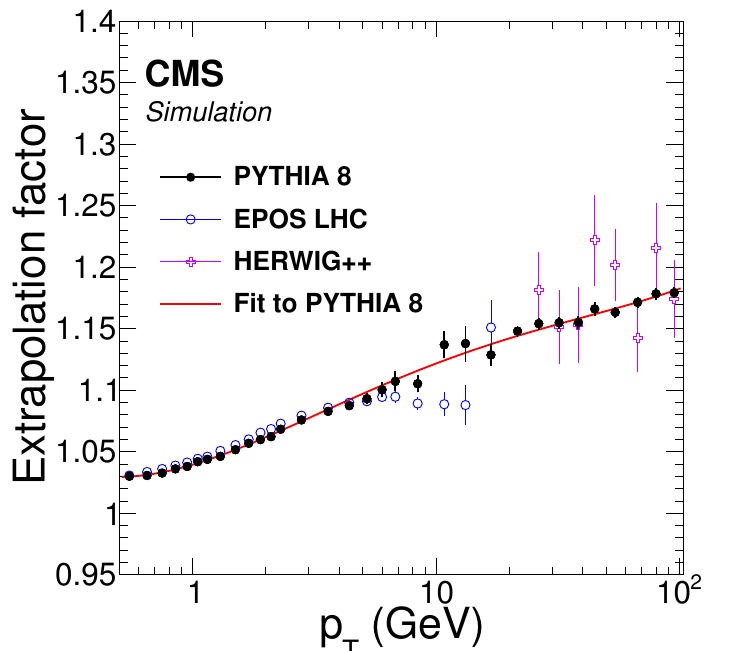
p s = 5 : 44 and 5.02 TeV for three